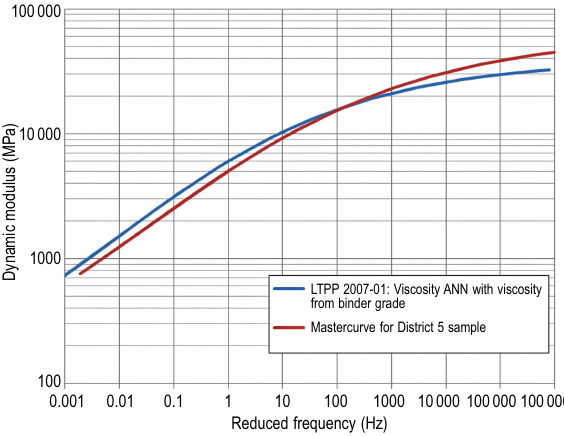
Figure 6 represents the tested dynamic modulus mastercurves and the LTPP predicted mastercurves for the New Mexico District 5. For this region